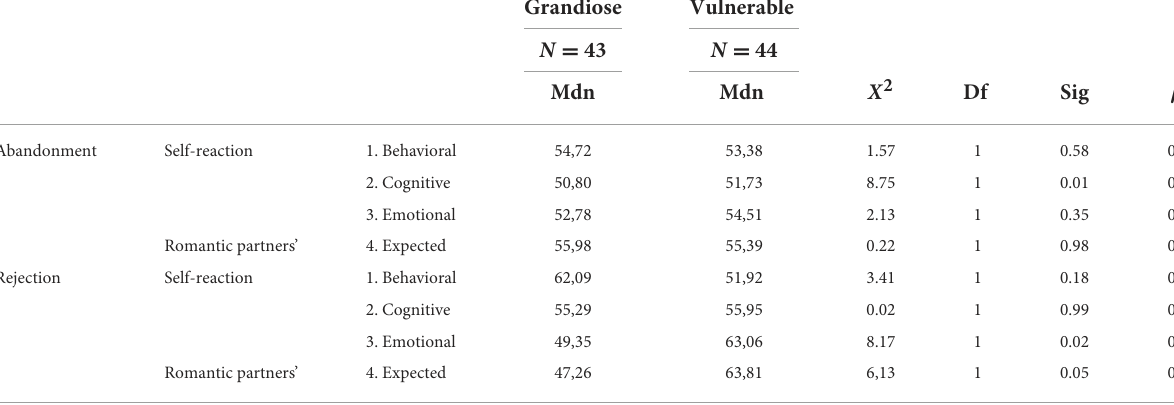
TABLE 1 Comparison of different levels of narcissism in terms of demographic characteristics.